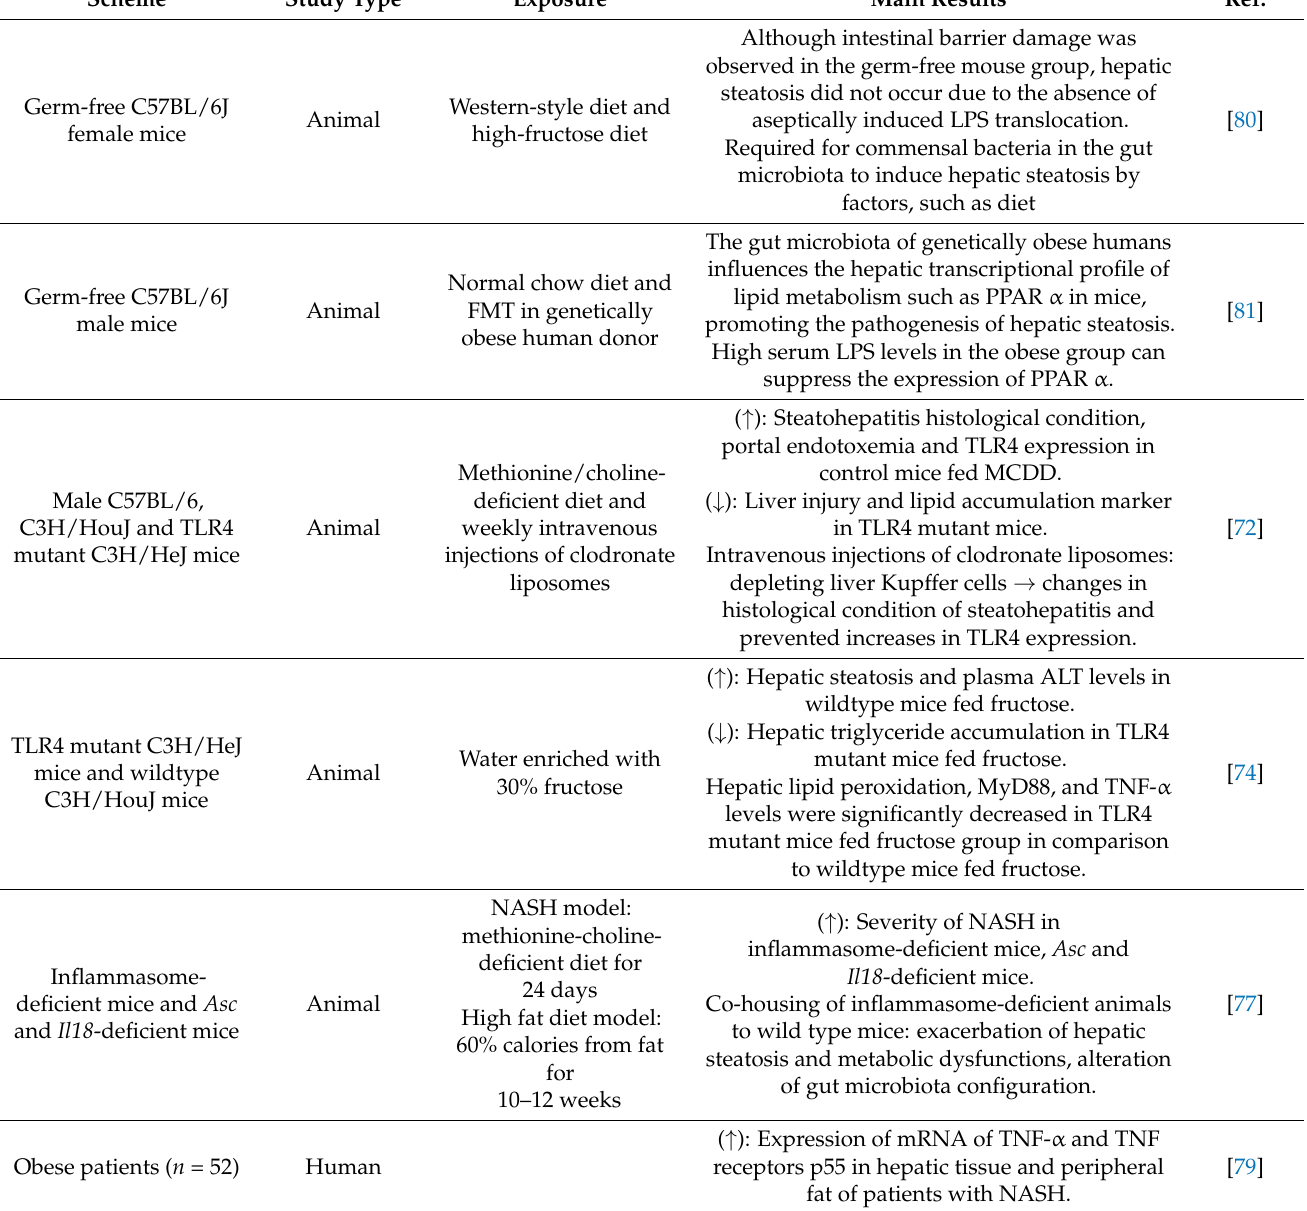
Table 1. Nonalcoholic fatty liver disease studies related to the immune